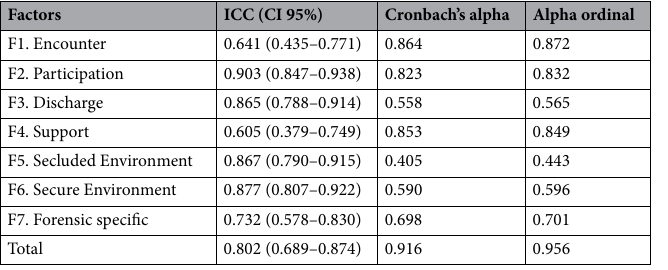
Table 4. Spanish QPC-FIPS. Test–retest ICC (n = 77) and Cronbach’s alpha. ICC Intraclass correlation coefficient, CI Confidence